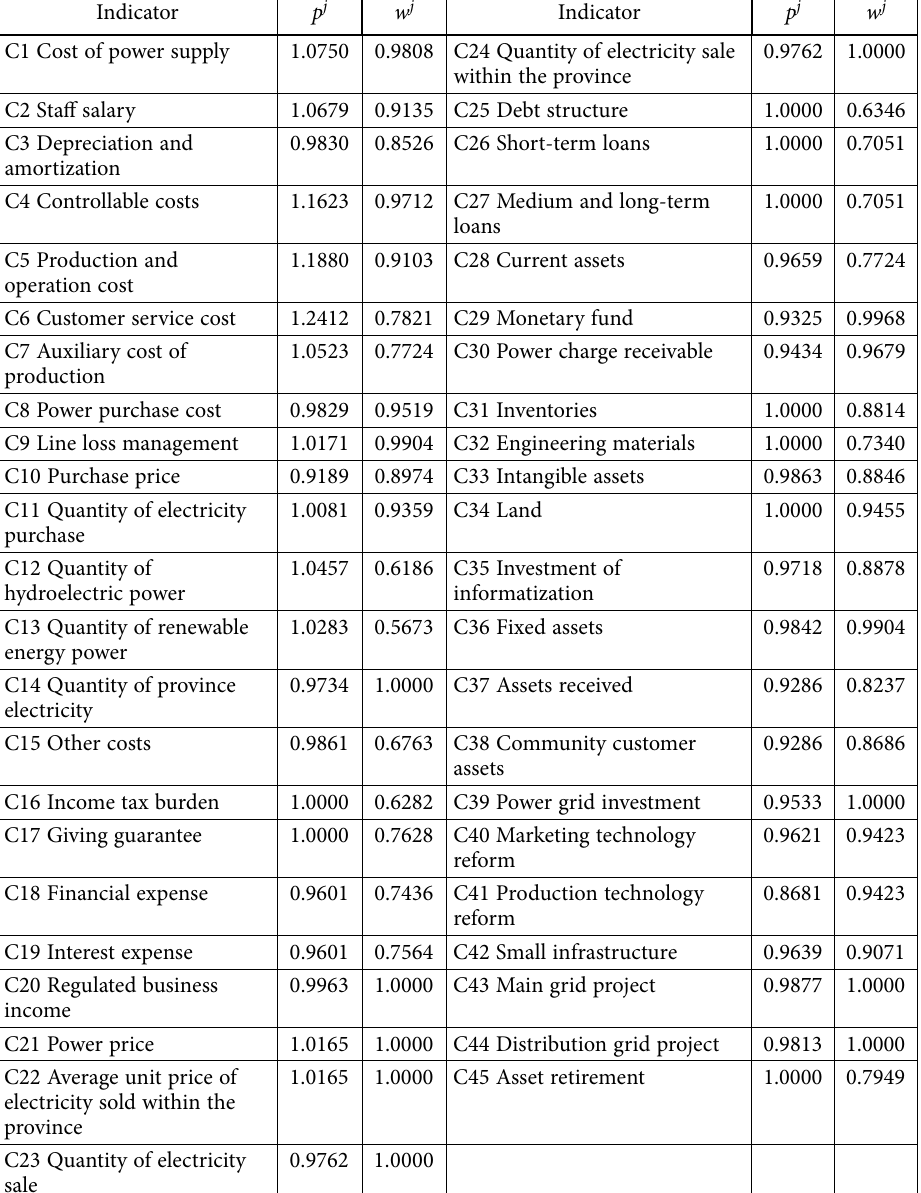
Table 3. List of indicators and their performance and importance (source: Yang et al., 2018) Indicator p j w j Indicator p j w